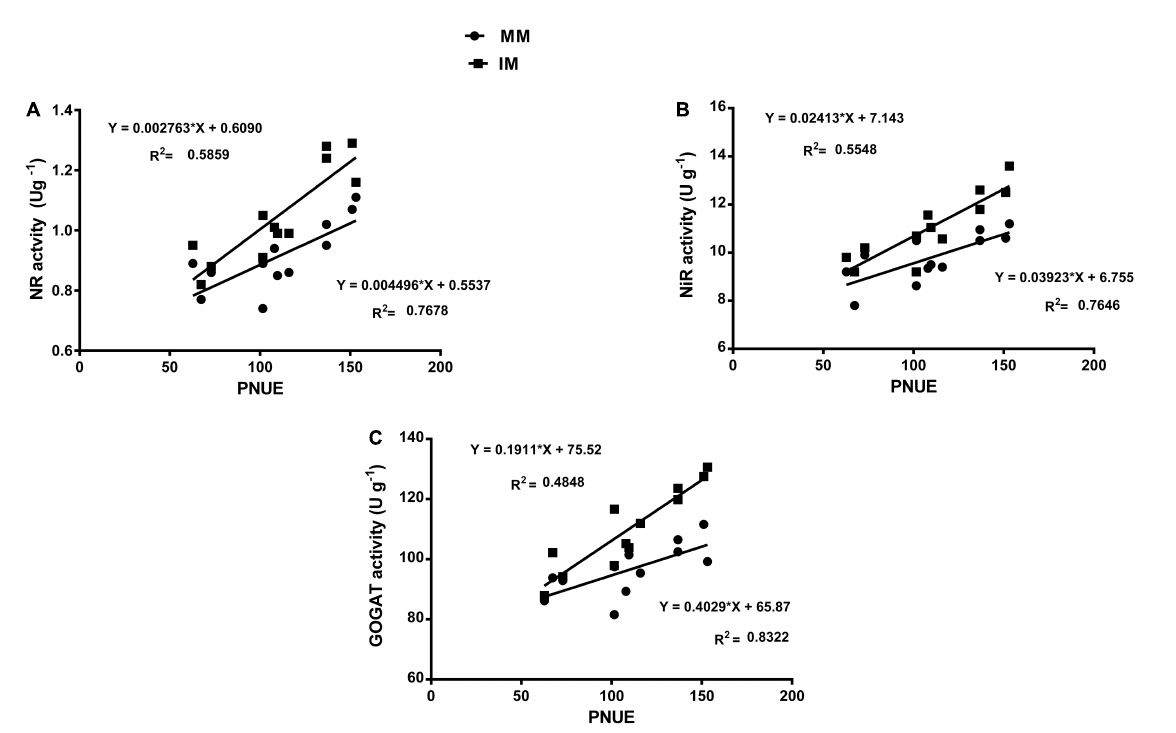
FIGURE8 Regression analysis of the photosynthetic nitrogen use efficiency with NR activity (A) , NiR activity (B) , and GOGAT activity (C) of maize leaf during mono-cropping and intercropping. MM, maize mono-cropping; IM, maize intercropping; PNUE, photosynthetic nitrogen use efficiency; NR, nitrate reductase; NiR, nitrite reductase; GOGAT, glutamate